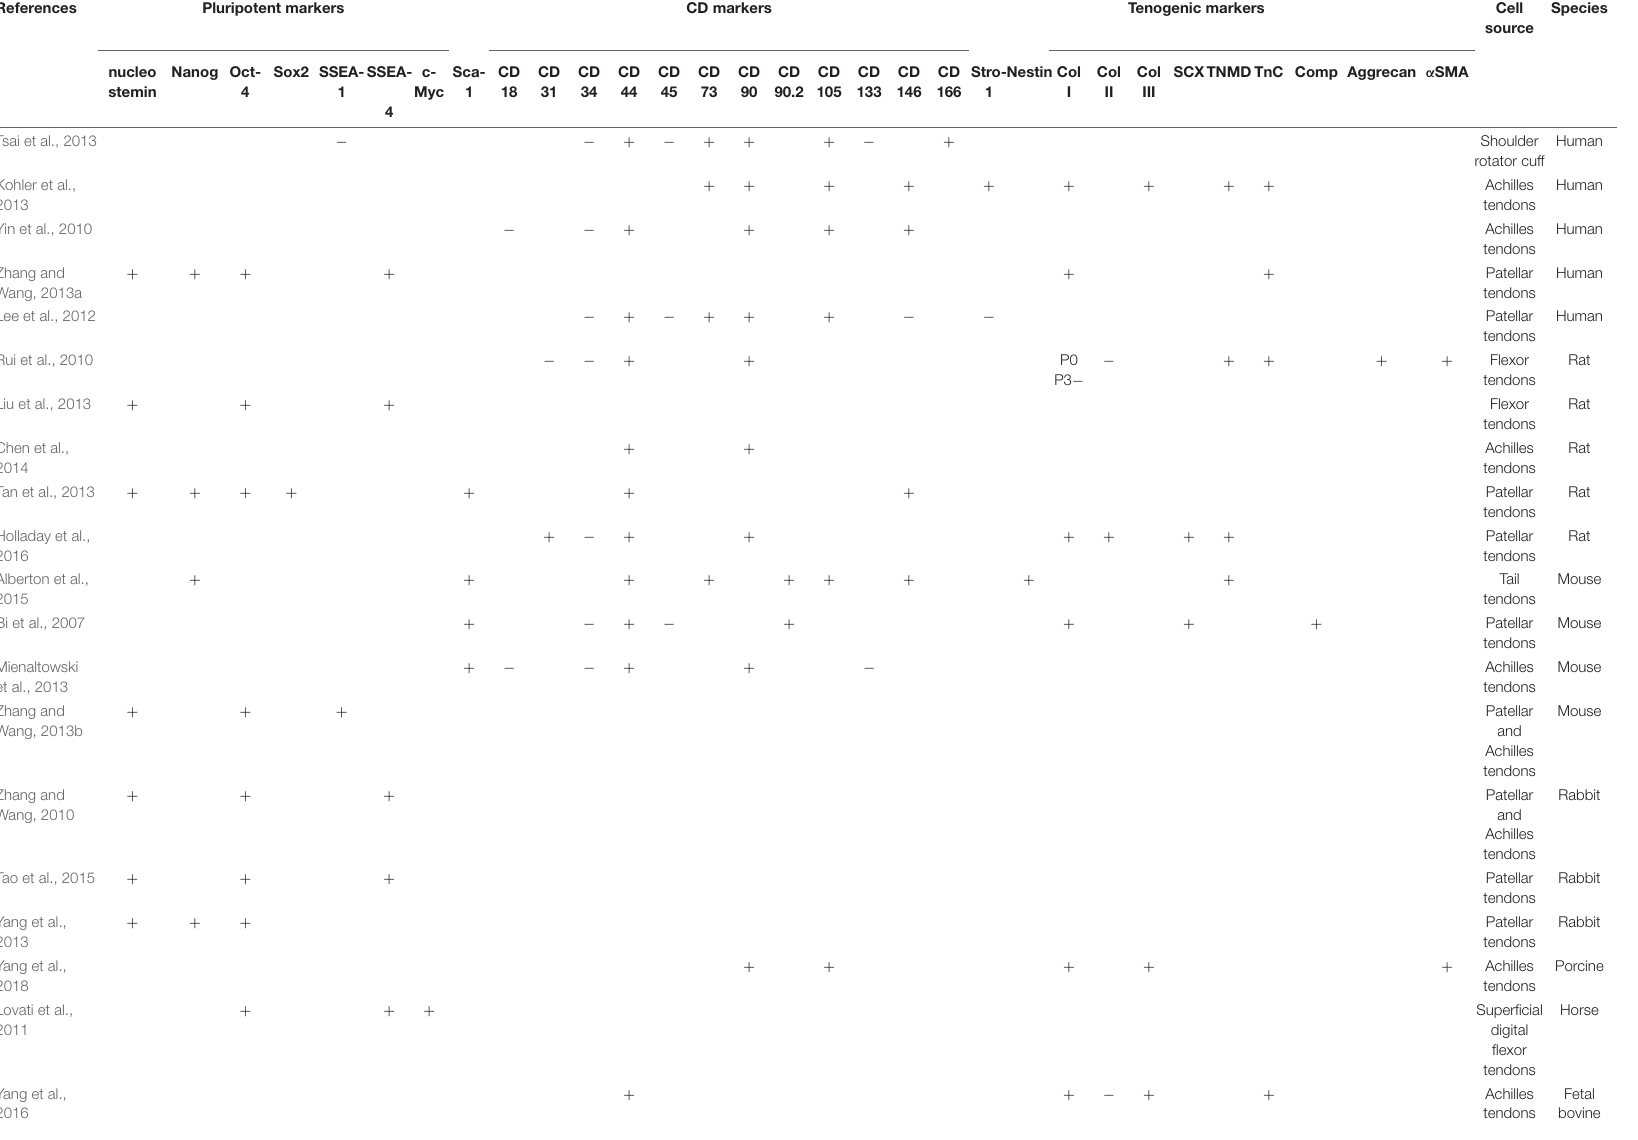
TABLE 2 | Expression of positive and negative markers in TDSCs in different species.